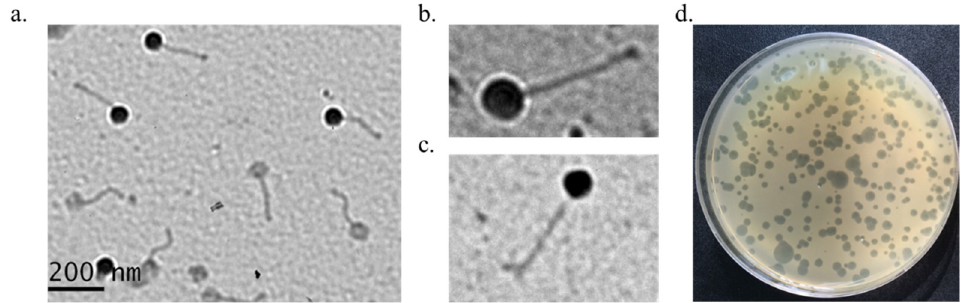
Figure 1. Transmission electron microscopy (TEM) images and plaque morphology of the isolated phages. ( a ) 2012-15 phage, ( b ) P1 phage, ( c ) P2 phage, ( d ) plaques of 2012–15 phage.